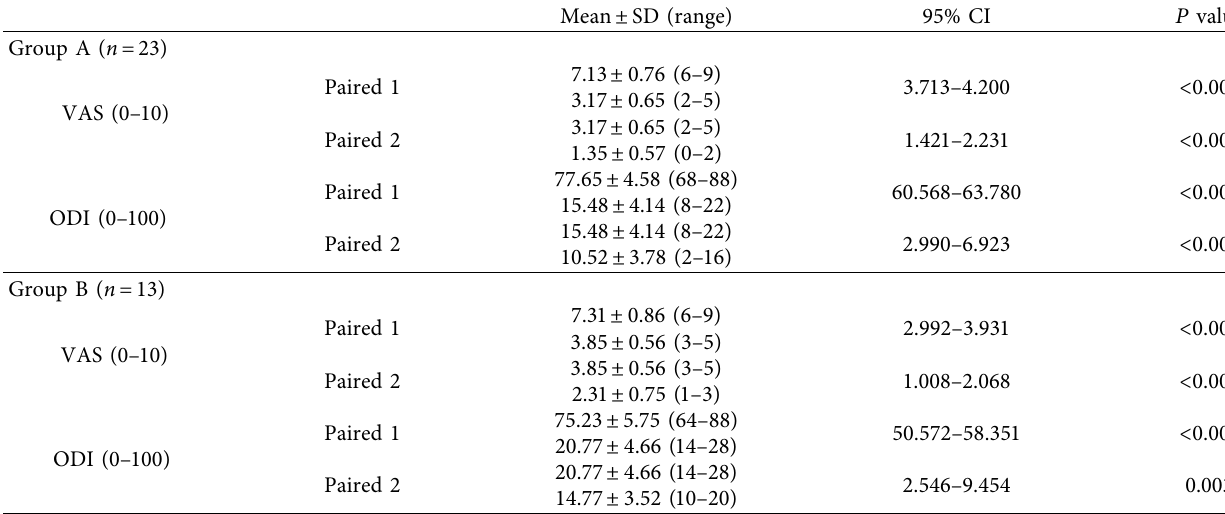
Table 2: VAS and ODI within-group